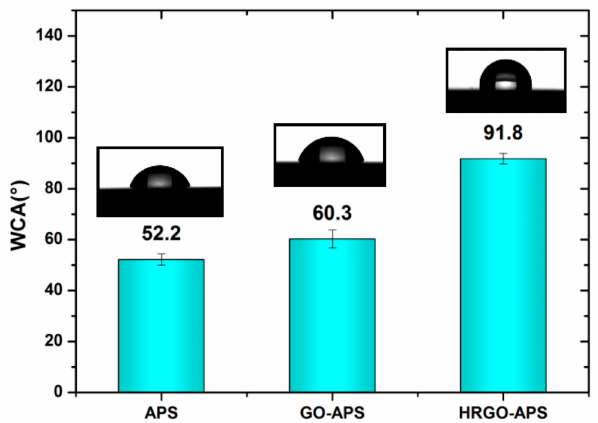
Figure 7. WCA data of hydroxylated APS coating, GO-APS coating and HRGO-APS coating (Insets are images of water droplets on tested